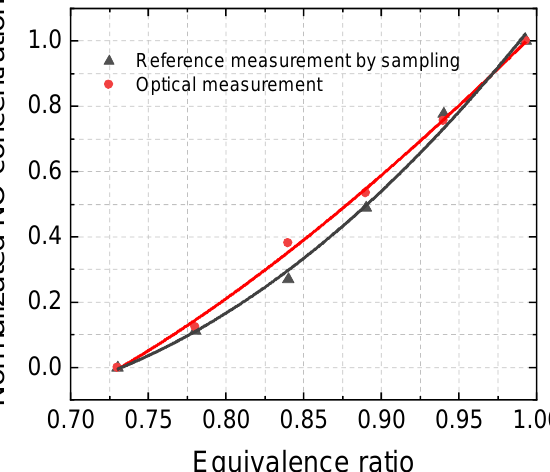
Figure 12. Normalized NO concentration in combustion gas measured by optical measurement and a gas analyzer in a premixed flat flame with an equivalence ratio of 0.99 – 0.73.